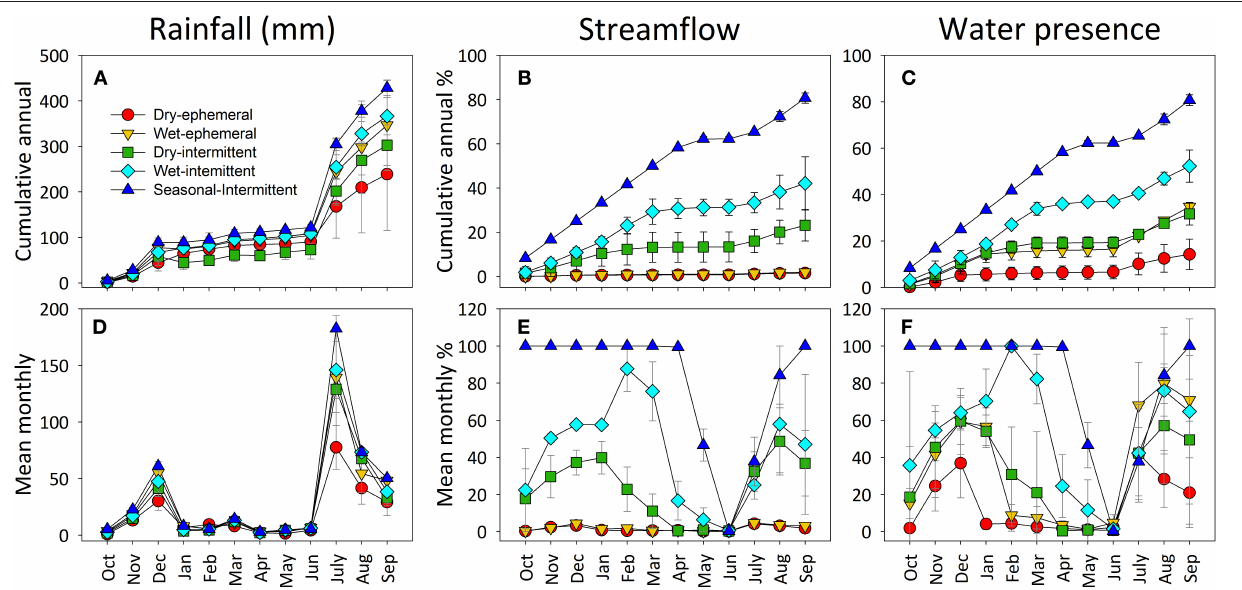
FIGURE 7 | Cumulative (A) monthly rainfall (mm), (B) cumulative monthly percent streamflow presence, (C) cumulative monthly percent water presence, and (D) mean monthly rainfall (mm), (E) mean monthly percent streamflow presence and (F) mean monthly percent water presence for each stream flow cluster class. Bars are standard